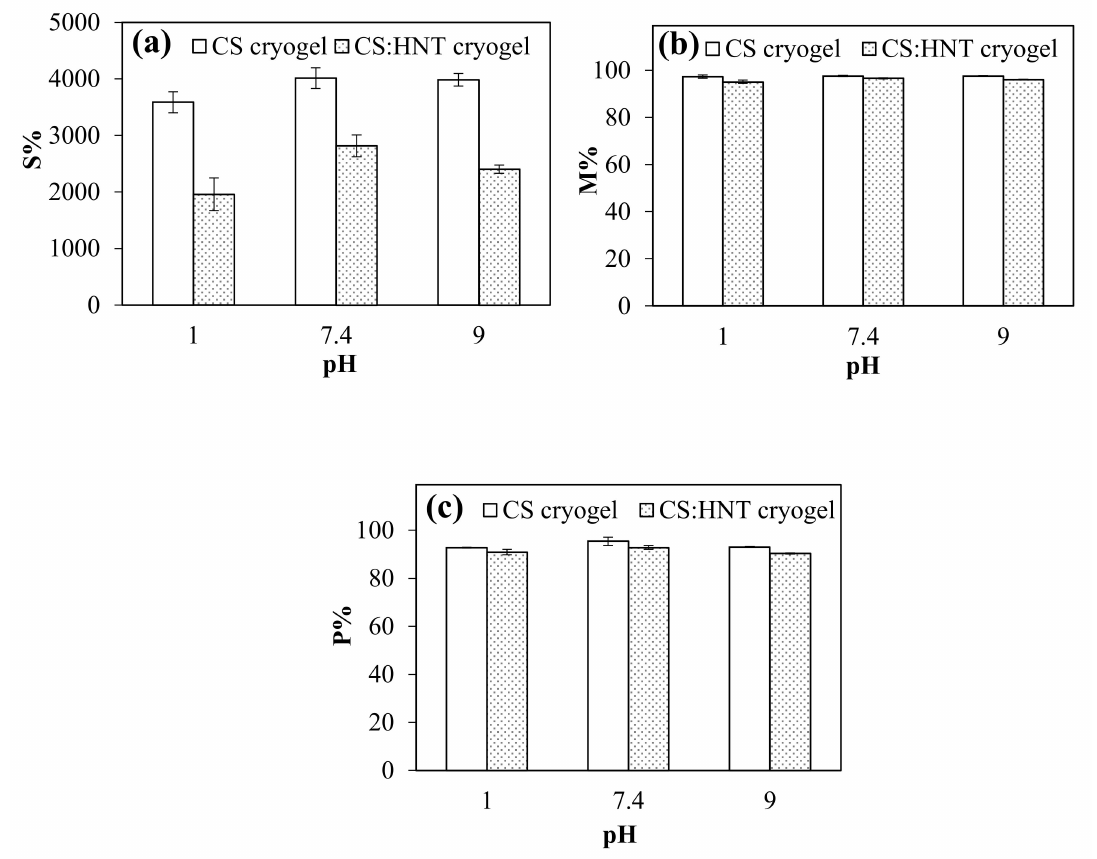
Figure 3. ( a ) Swelling ratio (S%), ( b ) moisture content (M%) and ( c ) porosity (P%) of CS and CS:HNT cryogel at pHs 1, 7.4 and